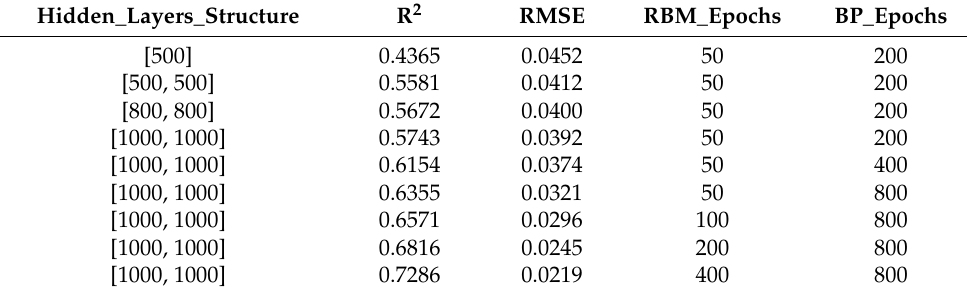
Table 3. Training parameters and results of the SMD-DBN model.